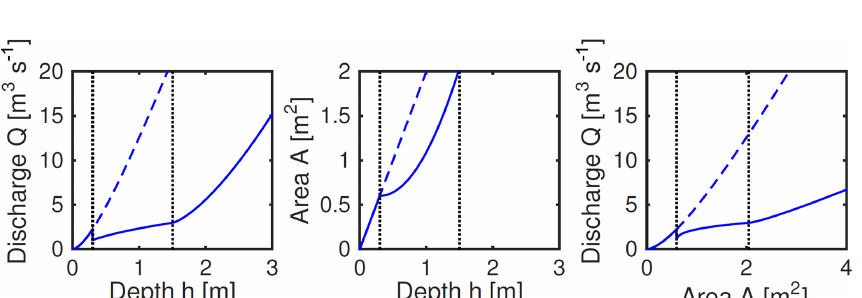
Figure 3. Flow modes for a leaky barrier.